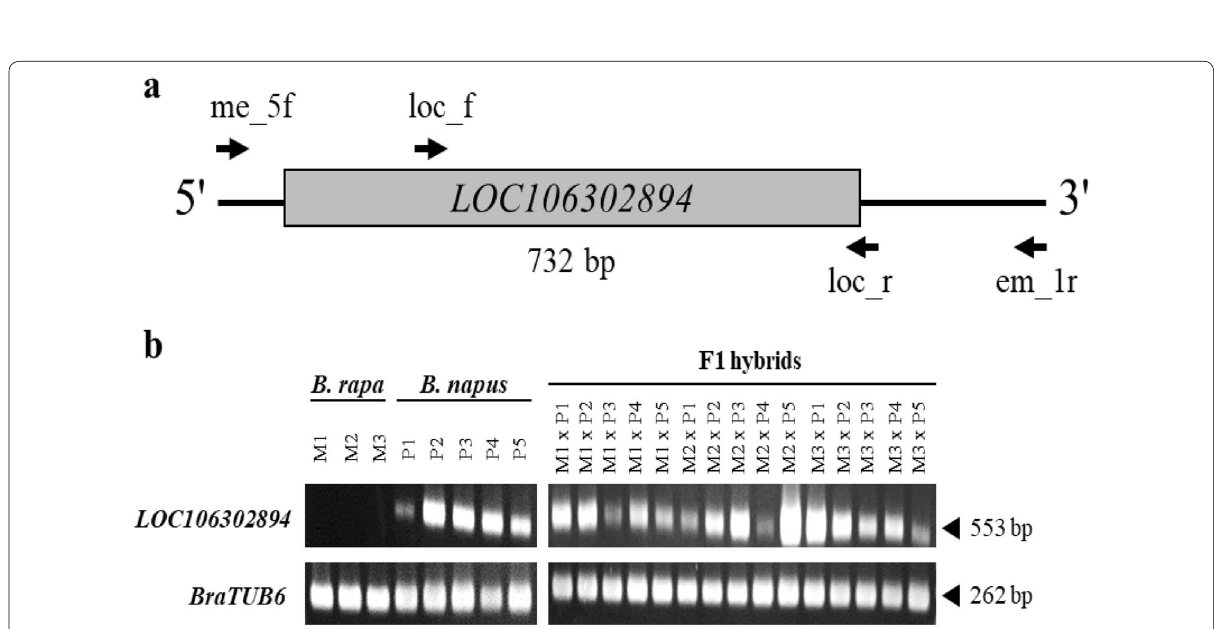
Fig. 5 Distinguishing B. rapa from B. napus and F 1 hybrids using the LOC106302894 gene primer set. a Diagram of LOC106302894 and position of primer set. b Detecting the presence of targeting in B. rapa , B. napus, and F1 hybrids. BraTUB6: internal positive control. M1: “Nongxing 80 days,” M2: “Wansheng rape,” M3: “Edible rape,” P1: “Deza oil No. 18,” P2: “Gueiza No. 4,” P3: “Zhong oil No. 36,” P4: “Wan oil No. 25,” and P5: “FTHEB